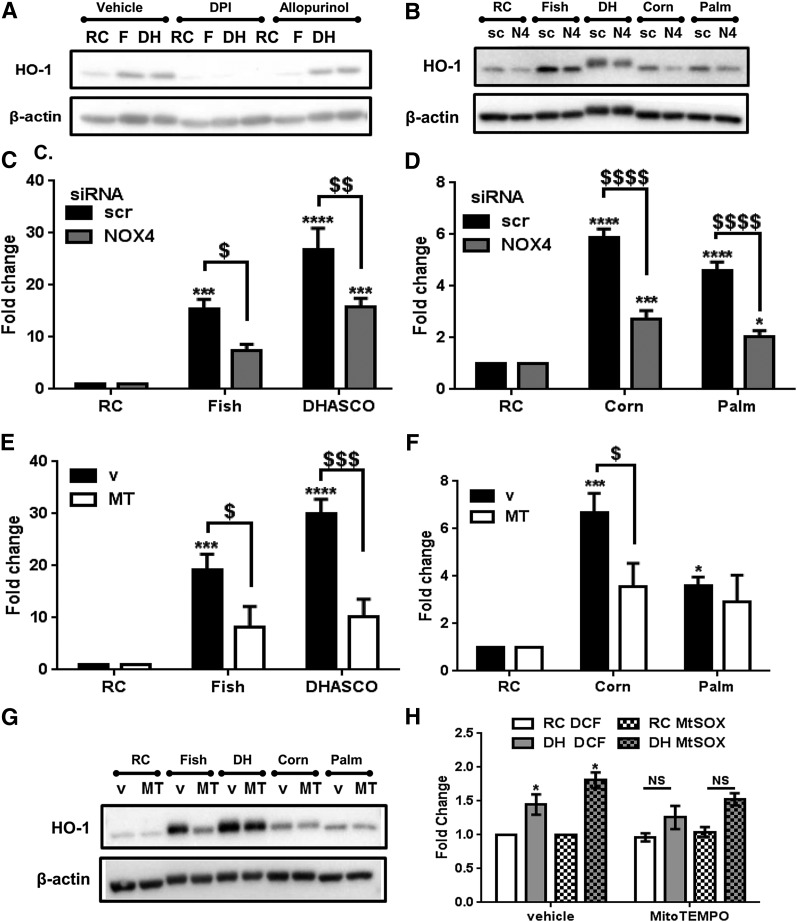
A-CRLP-driven HO-1 expression is controlled by NOX4 and mitochondrial ROS. A: After serum starvation, HAECs were pretreated with DMSO (vehicle), 5 μM diphenyleneiodonium, or 200 μM allopurinol for 1 h and then incubated with remnant control (RC), fish (F), or DHASCO® (DH) A-CRLPs (280 μM TG) in the continued presence or absence of inhibitor for 4 h. Representative HO-1 and β-actin blots from three independent experiments are shown. B–D: HAECs transfected with scrambled (scr/sc) siRNA or NOX4 (N4) siRNA were serum-starved then incubated with A-CRLPs for 4 h. B: Representative Western blots from three independent experiments. C, D: qPCR for HO-1 mRNA normalized to GAPDH presented as fold change of RC, mean ± SEM (n = 3). Two-way ANOVA with Bonferroni’s multiple comparisons test, scr versus NOX4 siRNA; $P < 0.05, $$P < 0.01, $$$$P < 0.0001. RC versus A-CRLPs: *P < 0.05, ***P < 0.001, ****P < 0.0001. E–G: Serum-starved HAECs were pretreated with DMSO (v) or 25 μM MitoTEMPO (MT) for 1 h then incubated with A-CRLPs for 4 h in the presence of DMSO or MT. E, F: qPCR for HO-1 mRNA normalized to GAPDH presented as fold change relative to RC, mean ± SEM, n = 3. Two-way ANOVA with Bonferroni’s multiple comparisons test, v versus MT; $P < 0.05, $$$P < 0.001. RC versus A-CRLP indicated; *P < 0.05, ***P < 0.001, ****P < 0.0001. G: Representative Western blots. H: HUVECs were pretreated with DMSO (vehicle) or 25 μM MitoTEMPO then incubated with RC or DHASCO® (DH) A-CRLPs in the presence of vehicle/MitoTEMPO for 2 h prior to loading with the ROS probe, 2′7′-DCF-DA (DCF), or MitoSOX (MtSOX) as indicated. Data are mean fold change relative to RC ± SEM (n = 3 with each experiment performed in technical quintuplet). Two-way ANOVA with Bonferroni’s multiple comparisons test, RC versus DHASCO®; *P < 0.05.